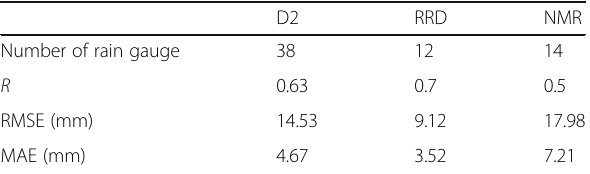
Table 5 Temporal correlation, RMSE, and MAE between CTL and Observation daily rainfall averaged for 38 locations for the JJA period in 1996, 1997, 1998, and 2006